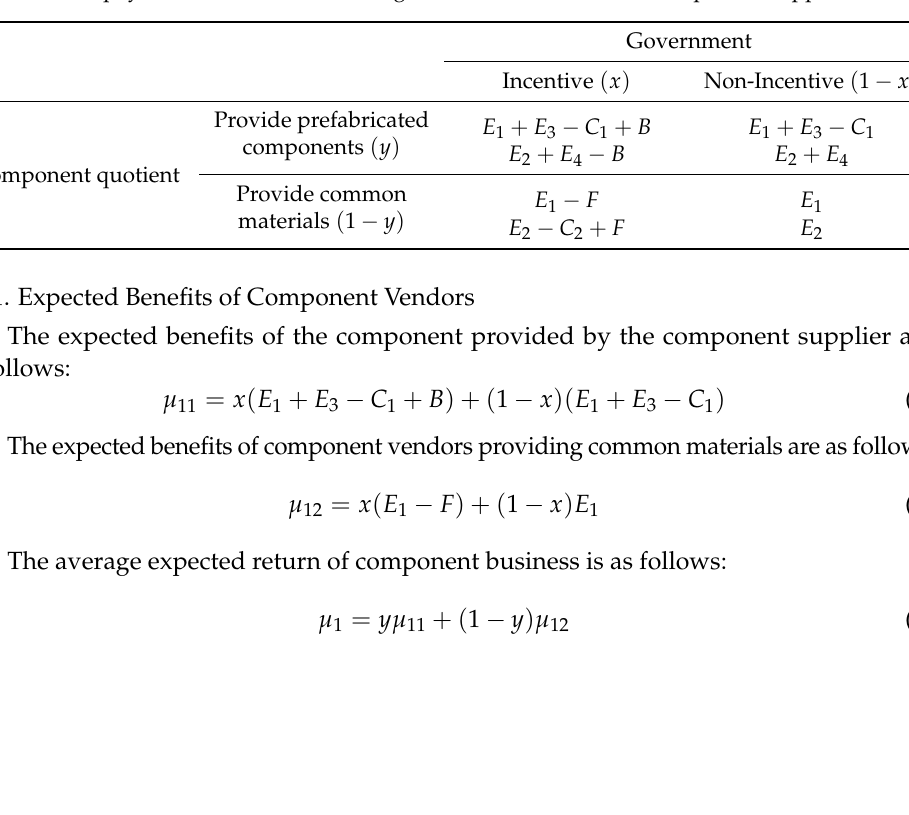
Table 1. Game payment matrix between the government and material component